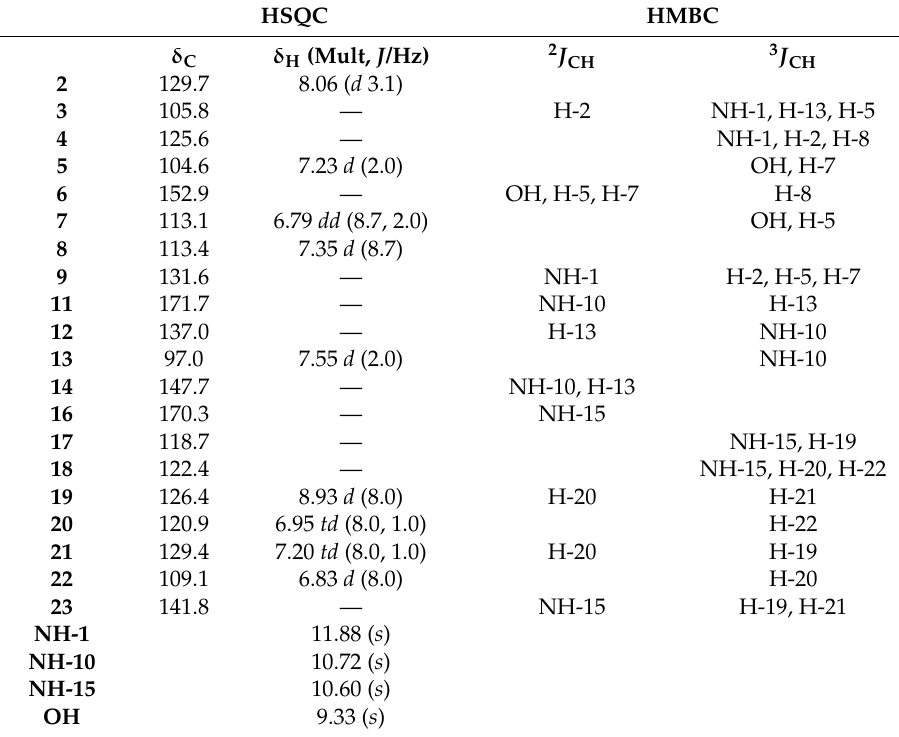
Table 1. 1 H- and 13 C-NMR spectrals data of VIO.